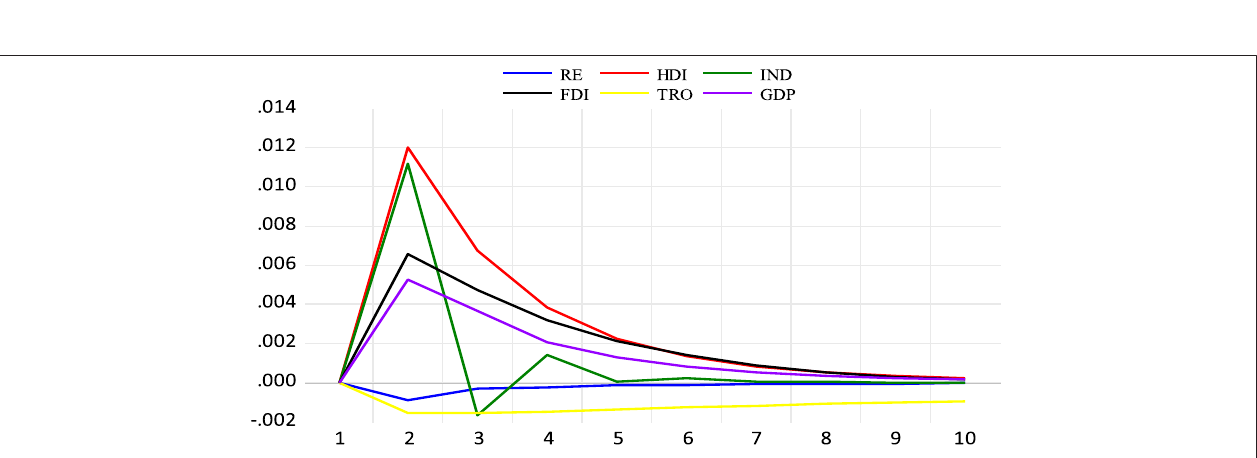
FIGURE 3 | Panel VAR impulse response functions for lower middle-income countries: Reaction of CO 2 emissions (CE) to renewable energy consumption (RE), humandevelopmentindex(HDI),industrialization(IND),foreigndirectinvestment(FDI),tradeopenness(TRO)andeconomicgrowth(GDP)onestandarddeviationshock.